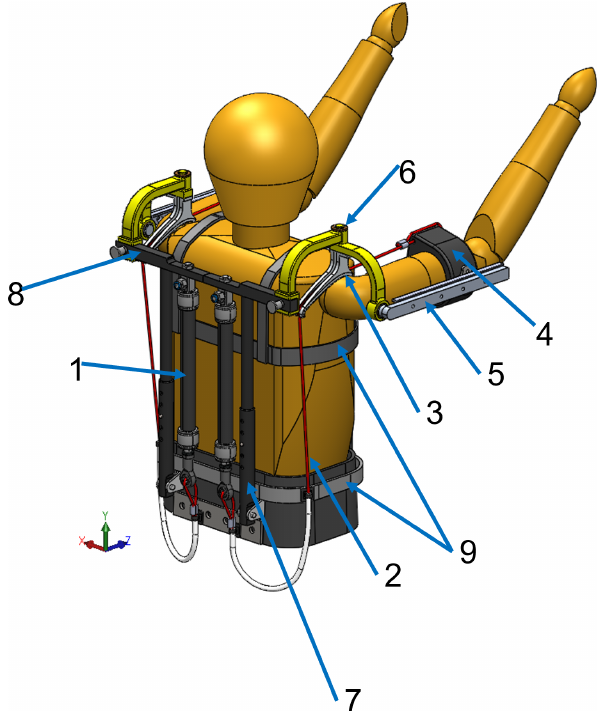
Figure 5. General structure of the exoskeleton.